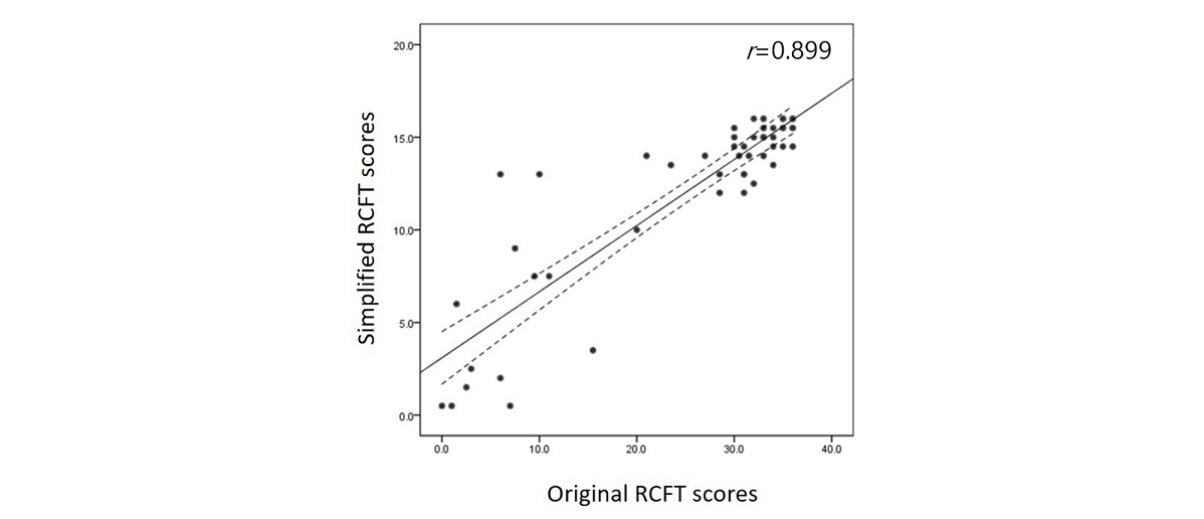
Figure 5. Correlation between original and simplified Rey-Osterrieth Complex Figure Test (RCFT) scores. All participants performed both original and simplified RCFTs. The simplified RCFT was manually scored separately in terms of both accuracy and placement, and it complied with the Meyers and Meyers’standardized scoring of the original RCFT. Raw scores ranging from 0.0 to 16.0 can be obtained. There was a significant linear relationship between the conventional and simplified RCFT scores (r=0.889; P